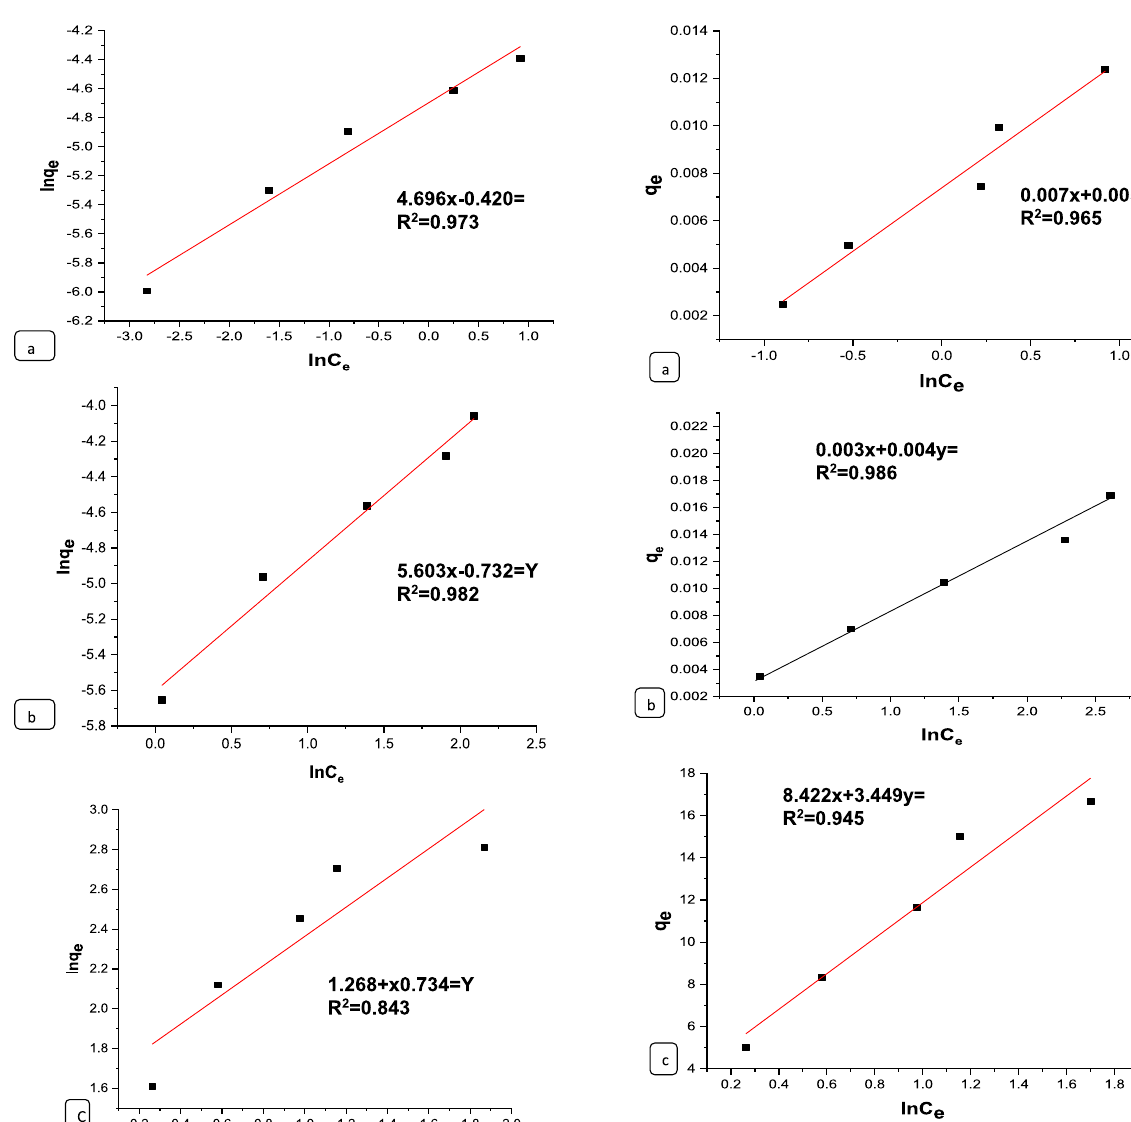
Fig. 19 Temkin a nano-bentonite, b MgO impregnated clay and c raw bentonite plots for adsorption of